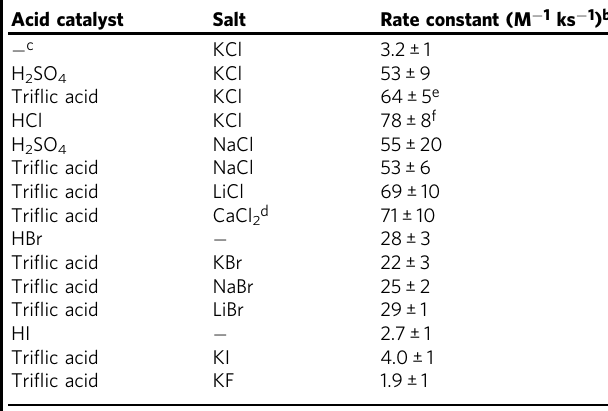
Table 2 Fructose conversion experimental results in